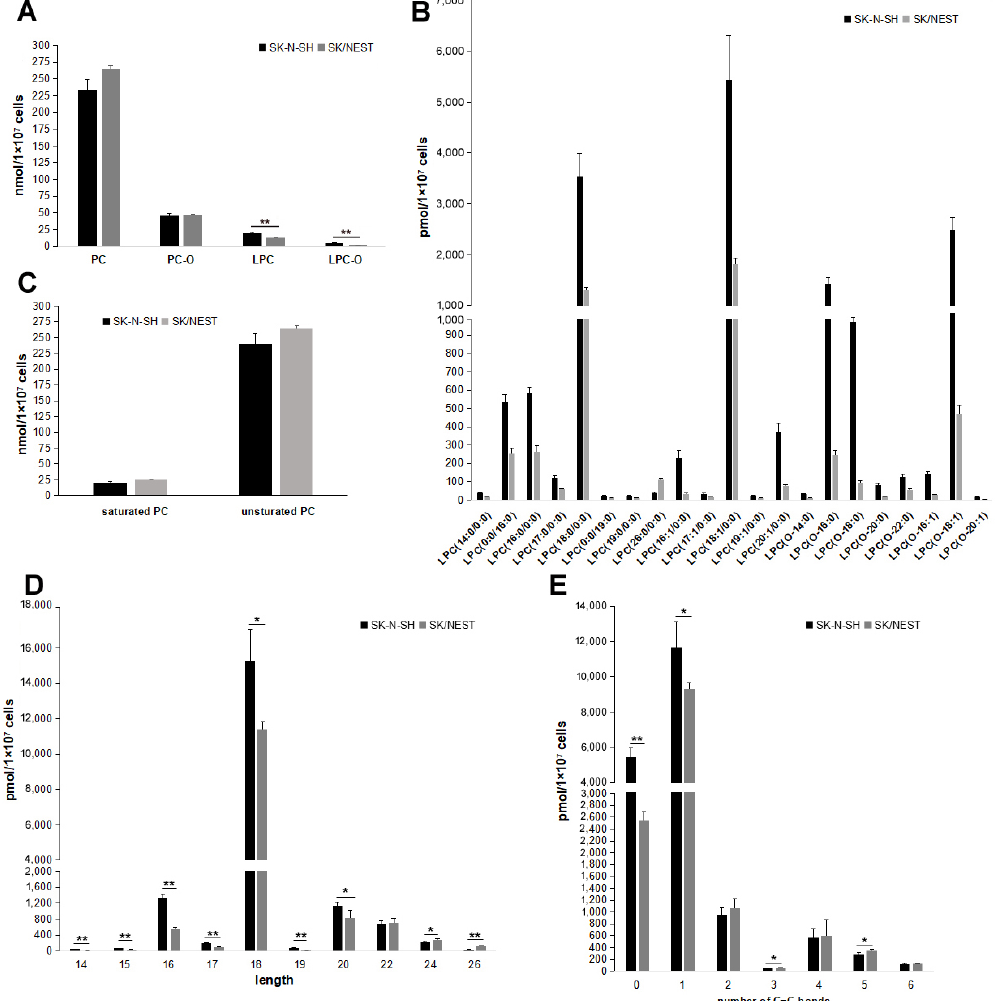
Figure 6. Overexpression of NEST affected the levels of LPC, but not PC in human neuroblastoma cells. ( A ) The levels of acyl-PC (PC), alkyl-PC (PC-O), acyl-LPC (LPC) and alkyl-LPC (LPC-O) were quantified in SK-N-SH and SK-NEST cells after OA incubation for overnight. ( B ) The levels of screened LPC and LPC-O between SK-N-SH and SK/NEST and control according to the standard, VIP ≥ 1, FC ≥ 2.0 or FC ≤ 0.50. Data are presented as means ± SD. All p < 0.01, n = 5. ( C ) The contents of total PC with saturated and unsaturated fatty acyl groups were compared between SK-N-SH and SK-NEST cells respectively. ( D , E ) Comparison of LPC levels with different length of fatty acyls ( D ) and number of C=C bonds ( E ). Data are presented as means ± SD. Asterisks indicate p values: * p < 0.05, ** p < 0.01, n = 5.